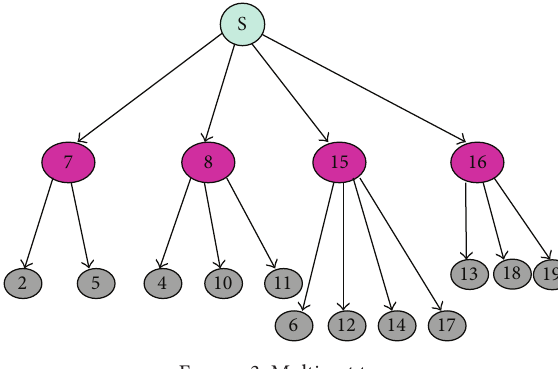
Figure 3: Multicast tree.